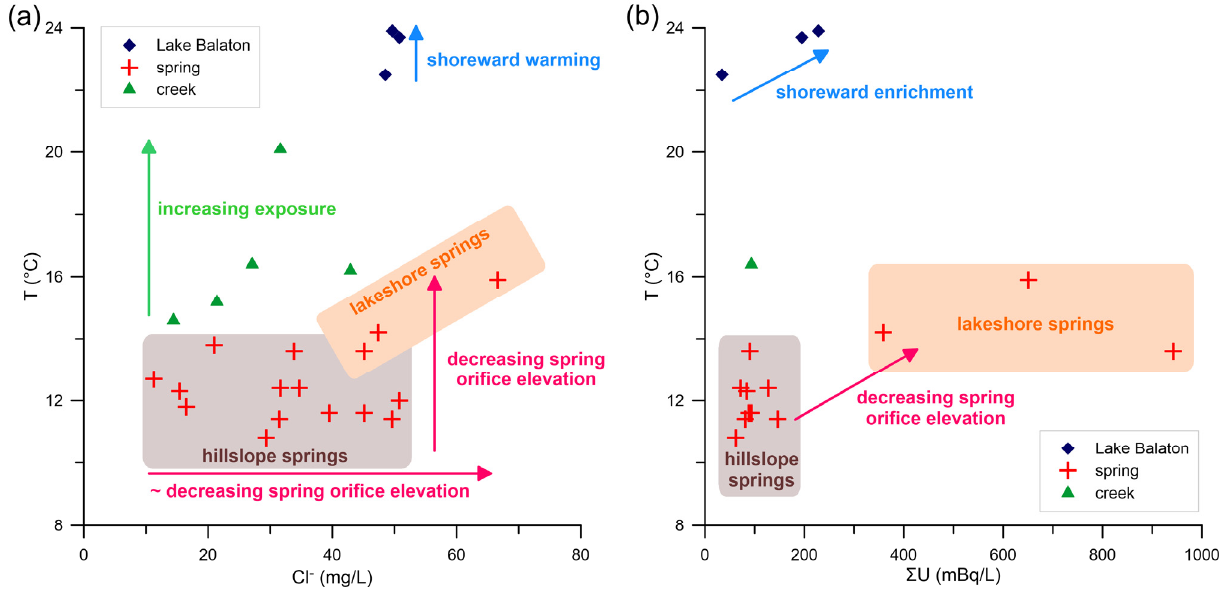
Figure 7. Plots of natural tracers of temperature (T), chloride concentration (Cl) and total uranium activity ( Σ U). ( a ) Cl vs. T, ( b ) Σ U vs. T.